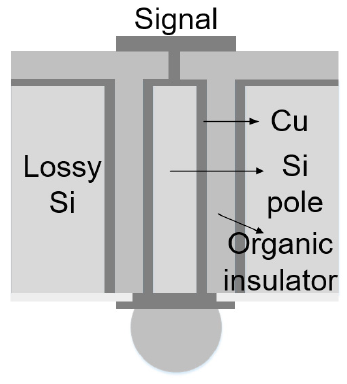
Figure 3. S-COV structure. Adapted with permission from [46], Copyright IEEE, 2017.